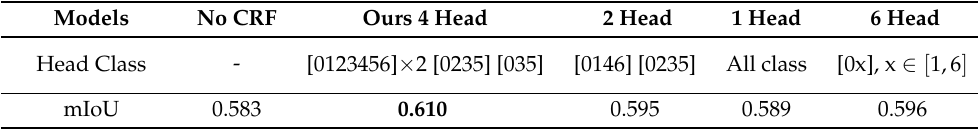
Table 3. Result Comparison of Different CRF kernels on Test Set